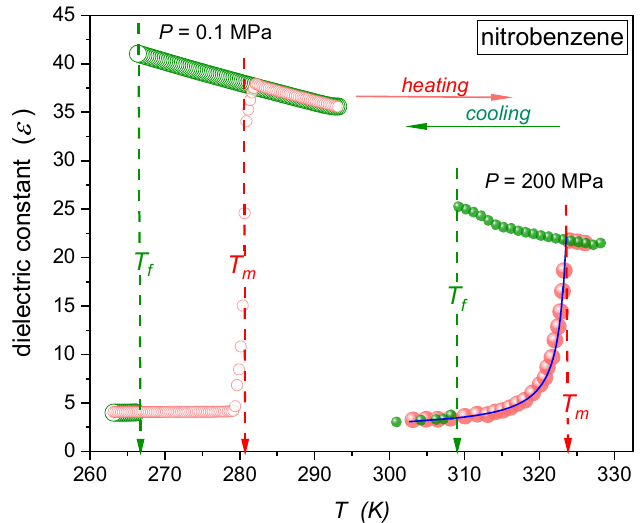
Figure 3. Temperature evolutions of dielectric constant related to melting ( T m , heating from the solid phase) and freezing ( T f , cooling from the liquid phase) in nitrobenzene, under atmospheric pressure, and for P = 200 MPa. For the latter, the curve portraying premelting anomaly is coupled to Equation (9), with exponent φ = 1. The curve is for the critical-like portrayal (Equation (9)) with the amplitude A = 19.89 K, singular temperature T ∗ = 324.5 K, the exponent γ = 1, and C = 2.181. The agreement with the Lipowsky model [37,38] and Equation (5) for liquid layers between crystalline solid plates is also notable. Recently, studies in menthol [25] and thymol [26] have shown similar behavior in approaching the melting temperature under atmospheric pressure. It was explained as the consequence of an ‘effective negative pressure’ formed within quasi-liquid layers between grains. It leads to the ‘rarefication’ of the liquid and the decrease of dipole–dipole intermolecular correlations, yielding conditions re- validating the Clausius–Mossotti model, and the description via Equation (6). The lack of the pretransitional effect below T f on cooling can be commented as the generic feature or the consequence of relatively ‘deep’ supercooling, causing the pretransitional domain close to the singular temperature to remain